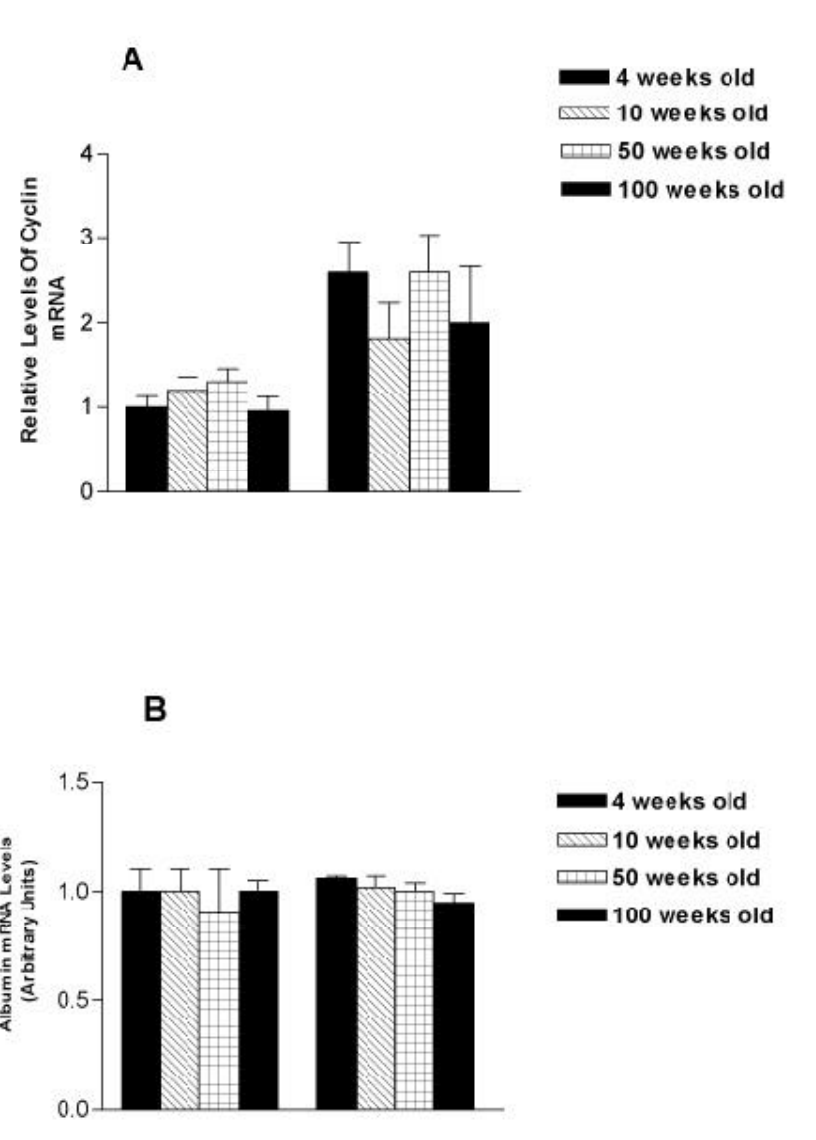
FIGURE 3. Cyclin (PCNA) mRNA in livers of various age groups. Relative levels of hepatic cyclin mRNA in control (left bar group) and Wy-14,643-treated rats (right bar group) normalized against albumin mRNA were determined by RT-PCR. Data are means + SEM of 4-6 animals per